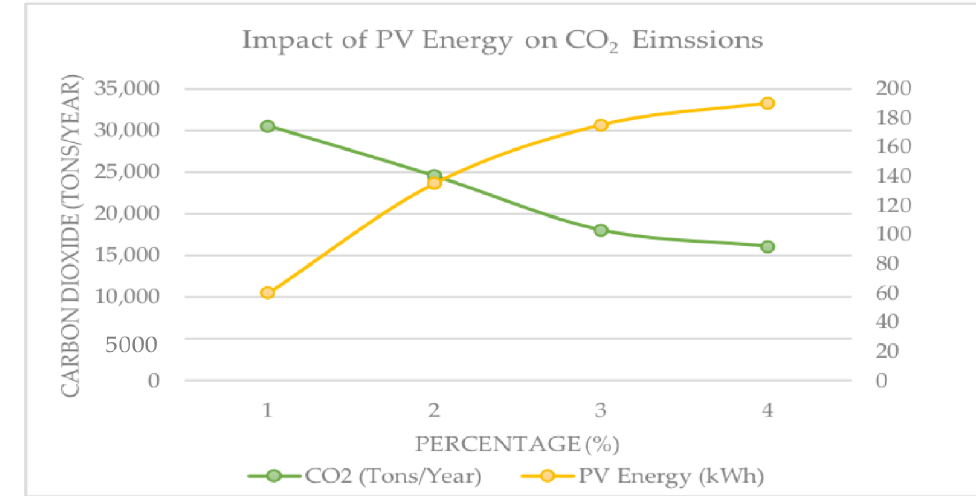
Figure 10. Impact of PV Energy Penetration on CO 2 .